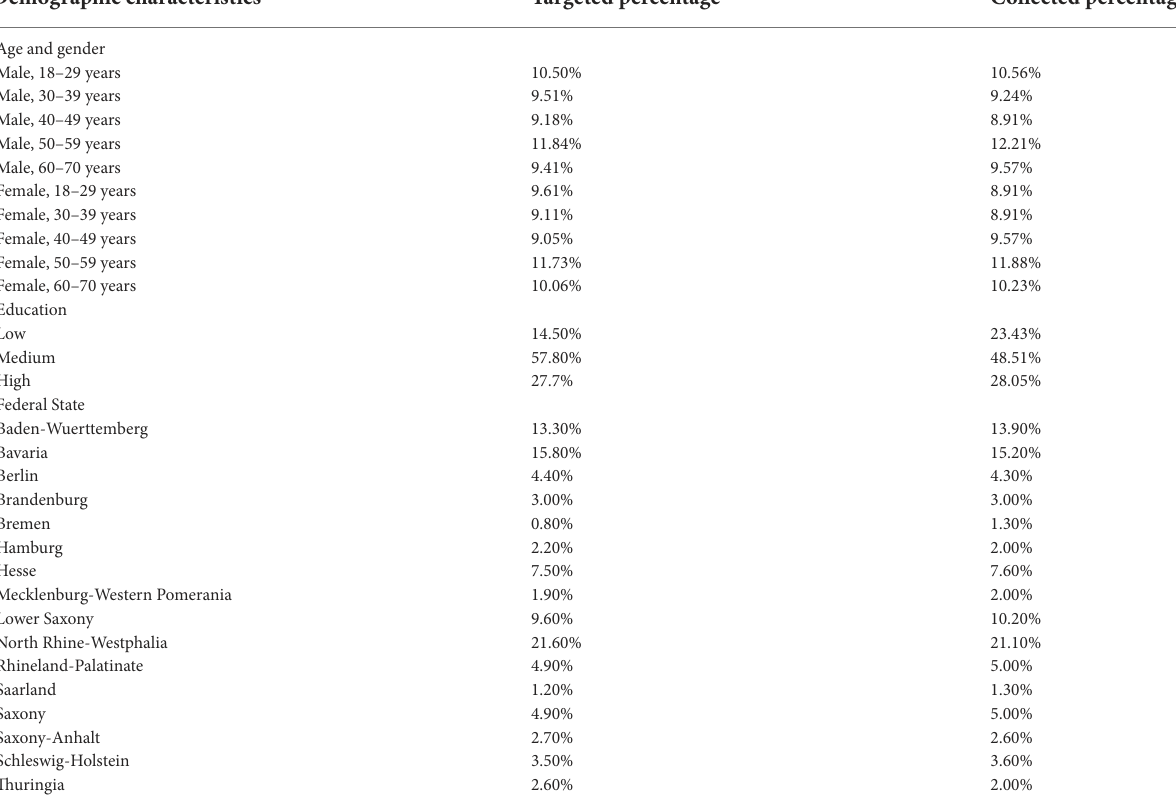
TABLE 2 Sociodemographiccharacteristics( n =303).